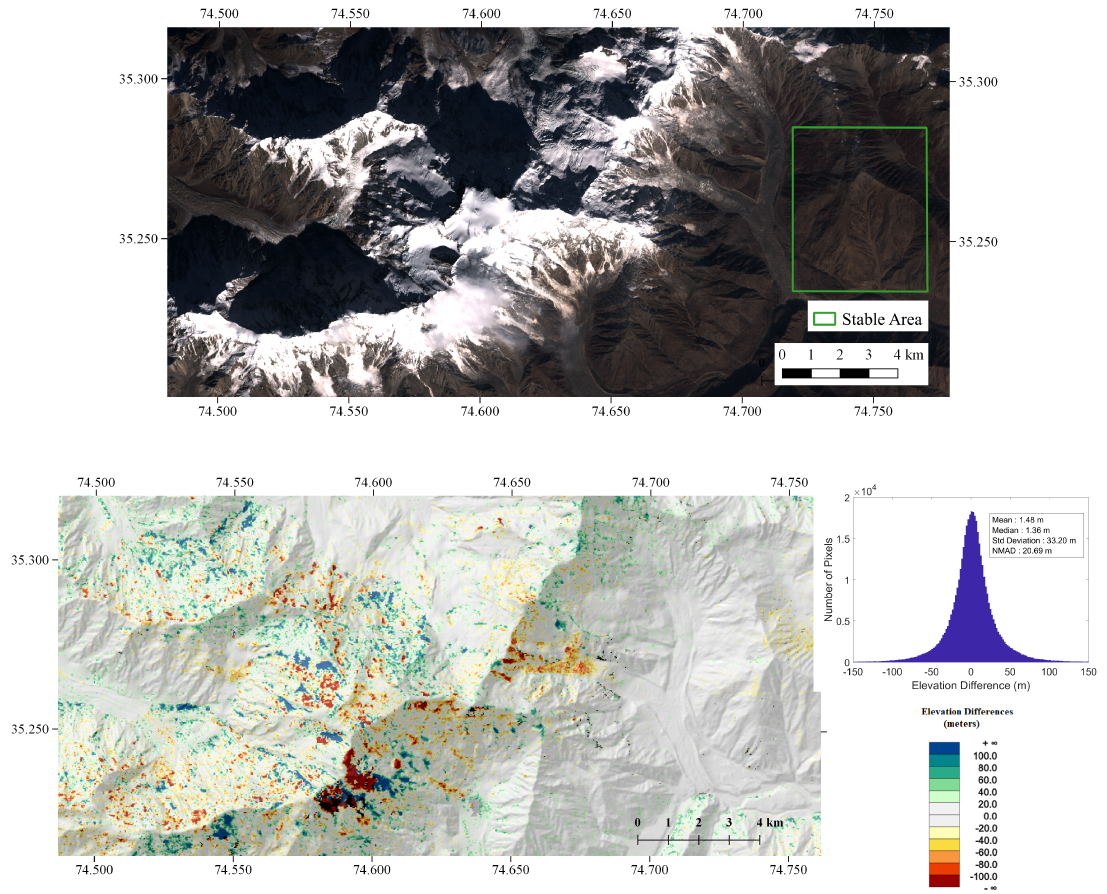
Figure 13. Elevation Differences between ALOS and PlanetScope DEM over Nanga Parbat: ( Top ) Sentinel Image of the area; and ( Bottom ) elevation differences along with the statistics.